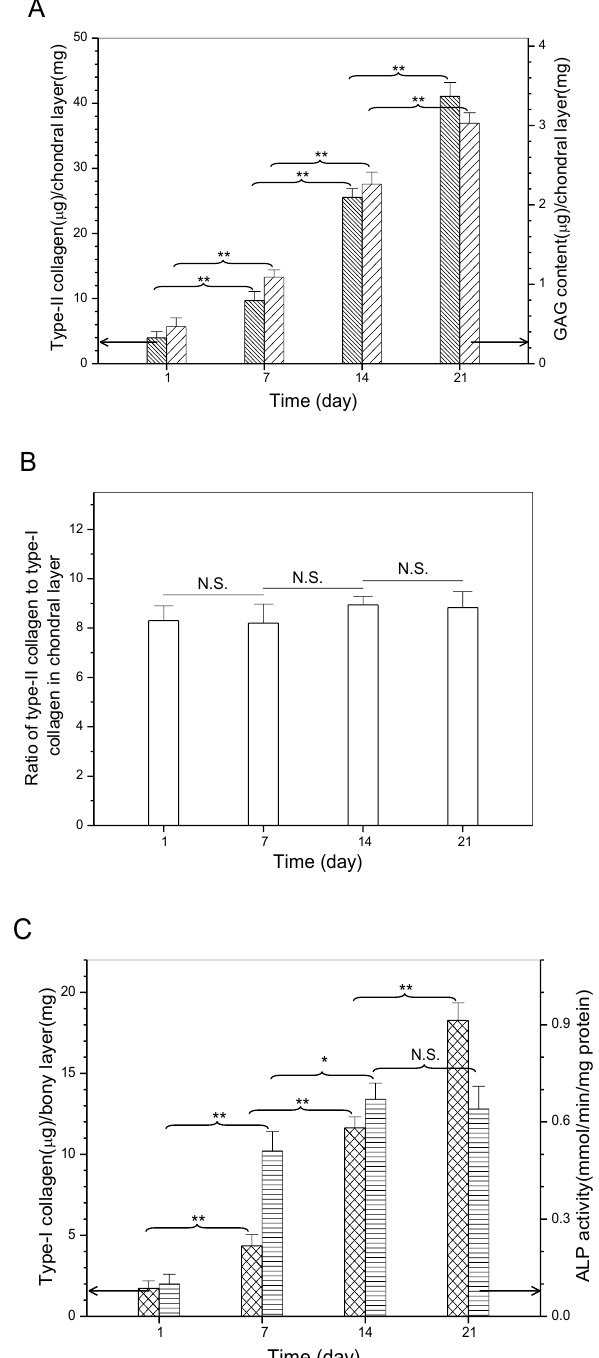
Figure 7. Biochemical assessment of matrix molecules in chondral layer ( A , B ) and bony layer ( C ) of layered scaffolds (* p < 0.05; ** p < 0.01; N.S., no significance).